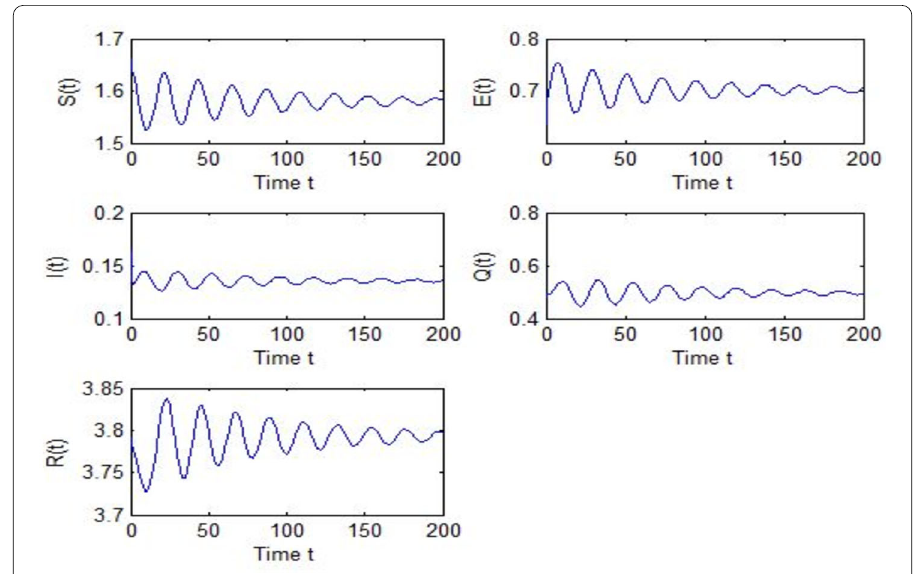
Figure 4 Evolutions of S , E , I , Q , R for τ 2 = 8.9951 > τ 20 along with time t